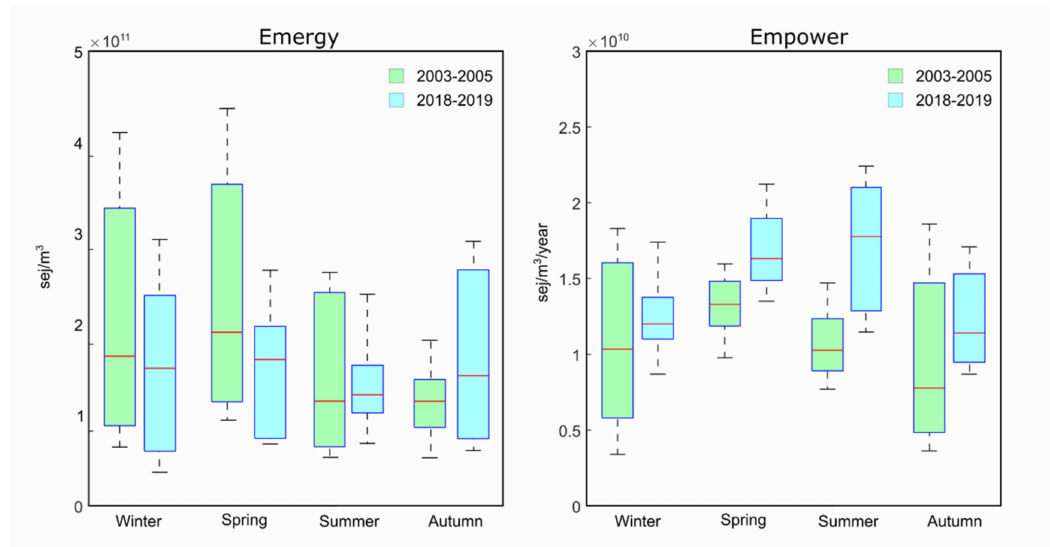
Figure 10. Seasonal average Emergy (sej/m 3 ) and Empower (sej/m 3 /year) in the two periods (2003–2005 and